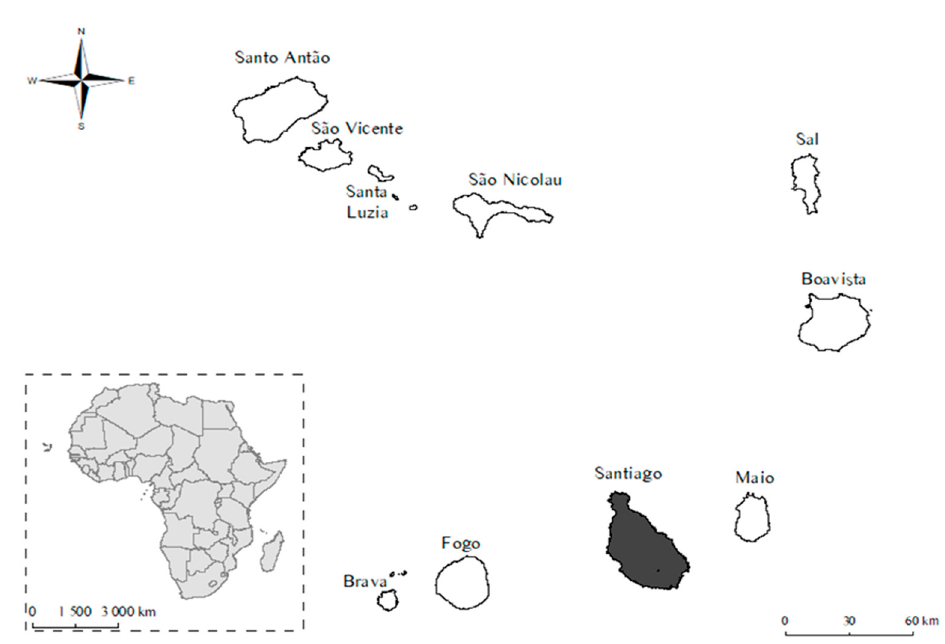
Figure 1. Cape Verde archipelago with its ten islands (Data from: Humanitarian Data Exchange).